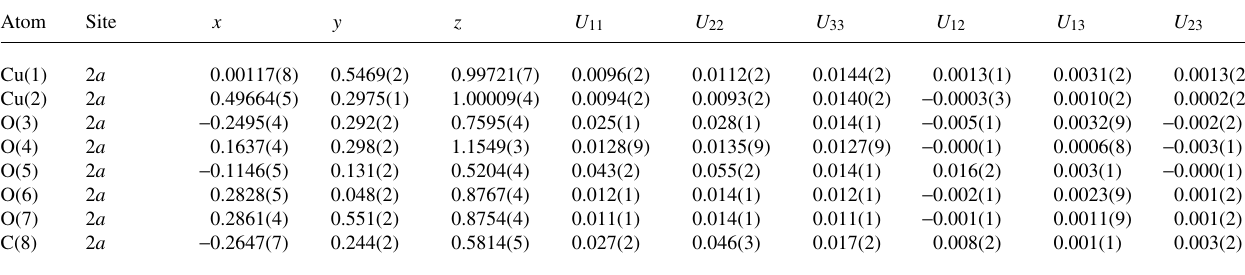
Table 3. Atomic coordinates and displacement parameters (in Å 2 ) .